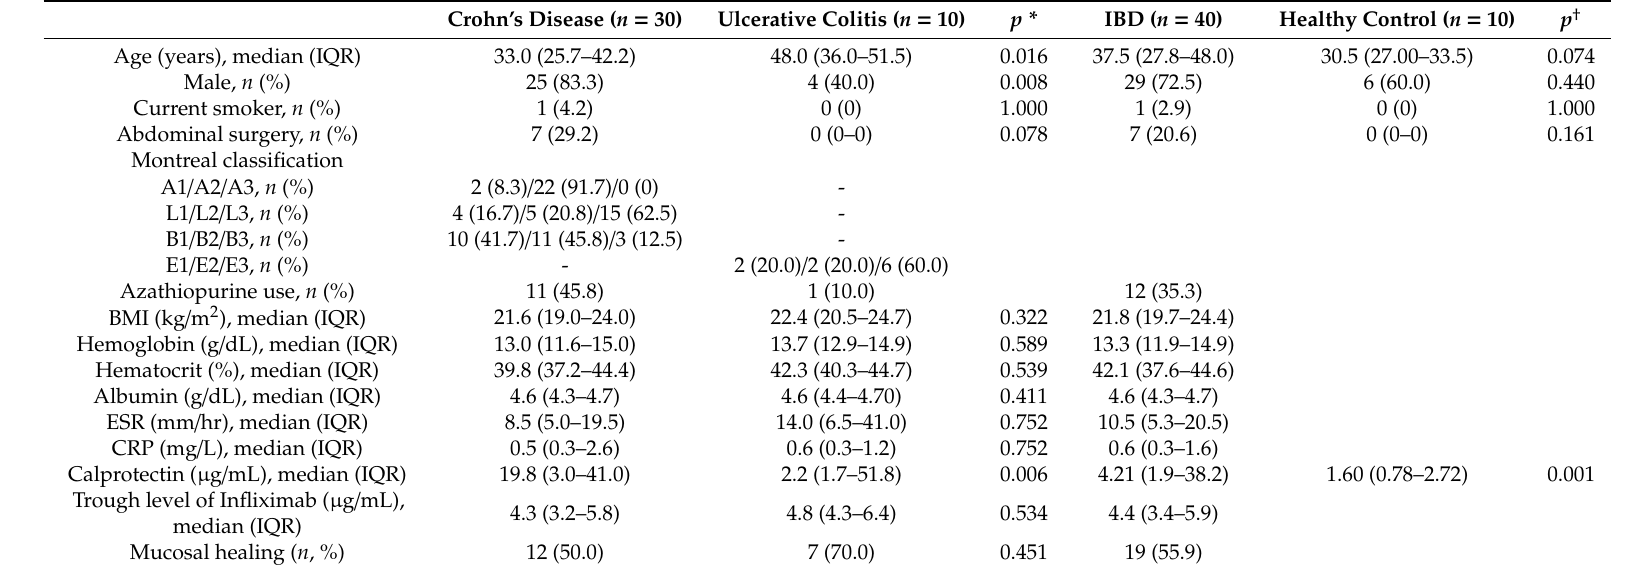
Table 1. Baseline characteristics of enrolled IBD